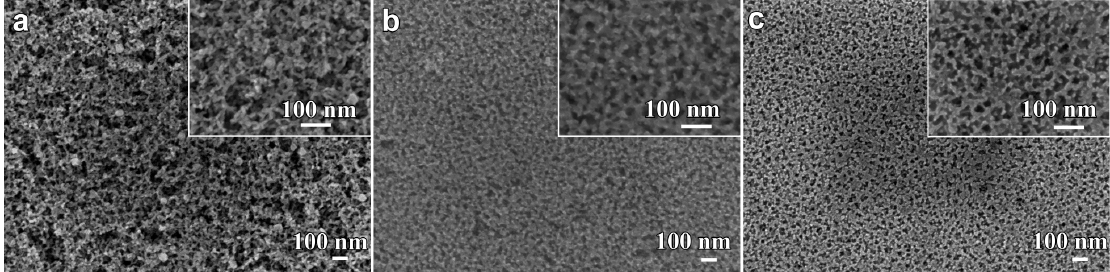
Figure 5. SEM morphology of nanocrystalline Fe 85.2 B 14 Cu 0.8 ( a ) Fe 85.2 B 12 P 2 Cu 0.8 ; ( b ) and Fe 85.2 B 10 P 4 Cu 0.8 ; ( c ) ribbons after immersion in 0.1 M H 2 SO 4 solution for 7.2 ks.